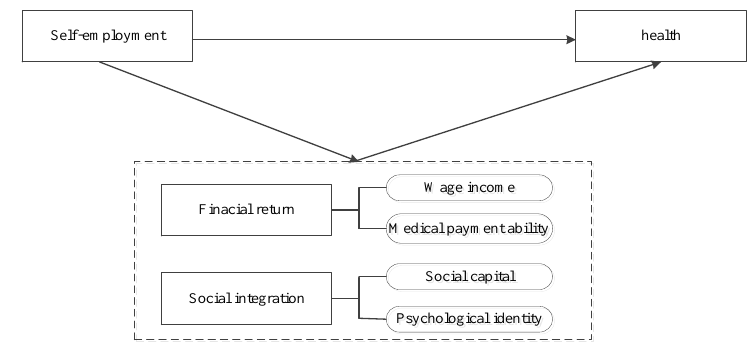
Figure 1. Theoretical analysis of self-employment affecting health.